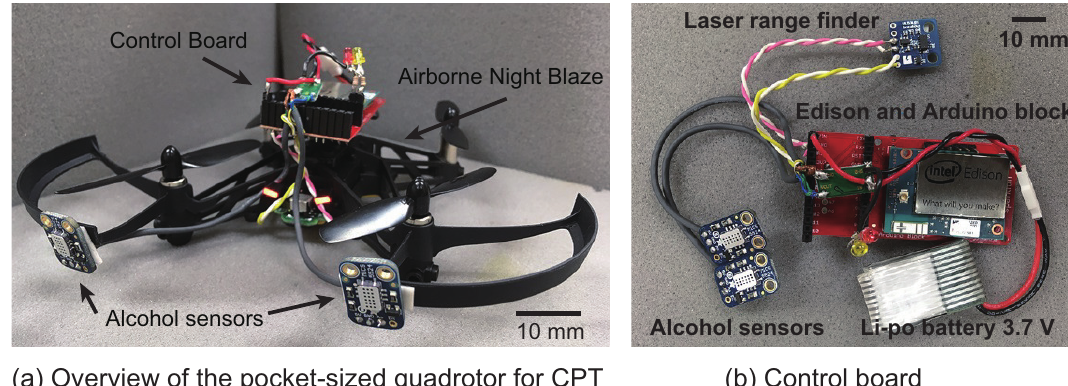
Figure 1. Overview of an autonomous pocket-sized quadcopter system for CPT. The system consists of a control board and a pocket-sized quadcopter.